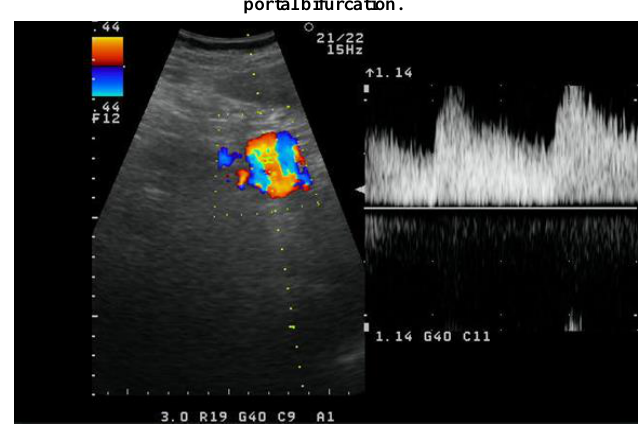
Fig. 4. Colour Doppler ultrasound image showing splenic artery aneurysm along with its spectral